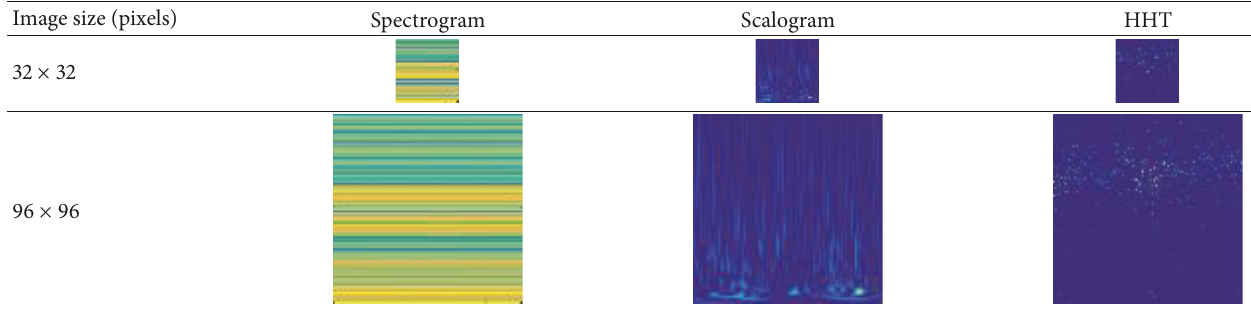
Table 5: MFPT outer race images.